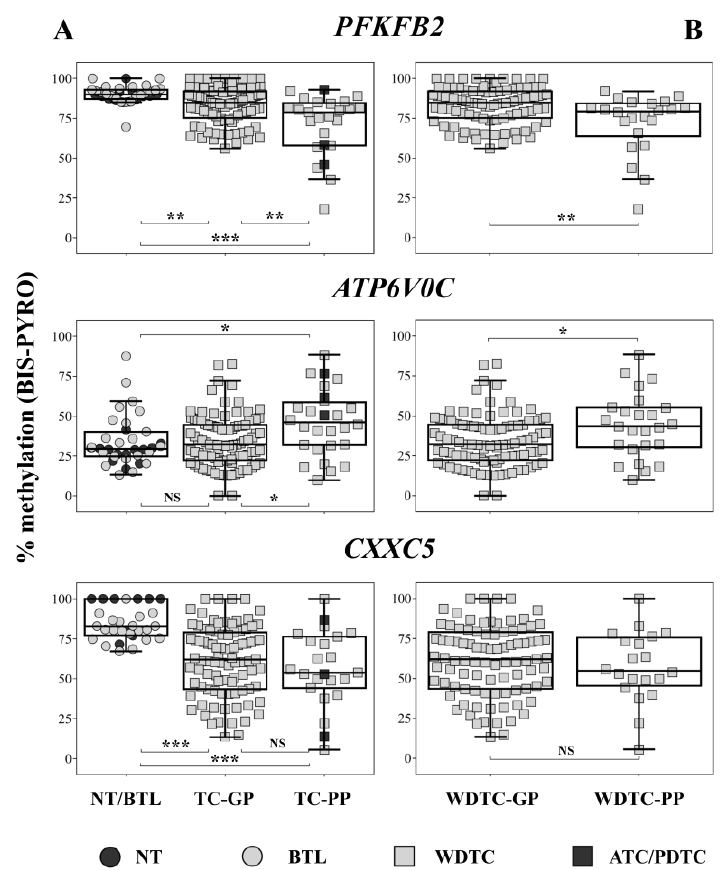
Figure 2. Bisulfite pyrosequencing quantification of CpG methylation in PFKFB2 , CXXC5, and ATPV6V0 . ( A ) Kruskal-Wallis and Dunn ’ s post-hoc tests were applied to compare non-neoplastic thyroid samples (NT/BTL) and carcinomas from patients with good (TC-GP) and poor prognosis (TC-PP). ( B ) Comparison between poor prognosis (WDTC-PP) and good prognosis (WDTC-GP)